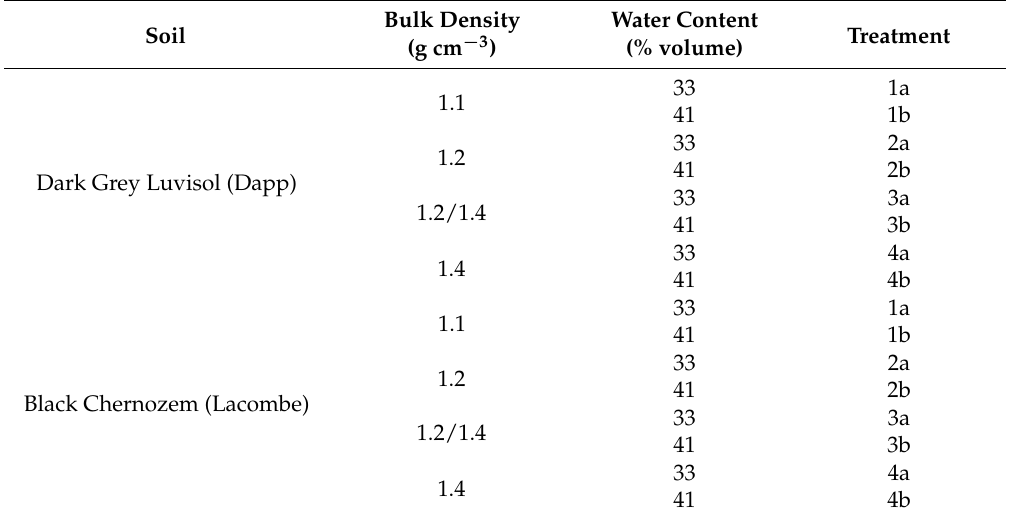
Table 2. Treatment list during the greenhouse pot experiment. Shows the treatment description for the soil pots ( n = 48) in the faba bean phase, where three experimental units were used for each treatment combination. Eight different fixed effect treatments of bulk density and volumetric water content were applied in both soil types, with conditions representative of the entire pot (20.5 cm height, 17.5 cm inner bottom diameter, 19.5 cm top diameter, with an 18.0 cm soil column